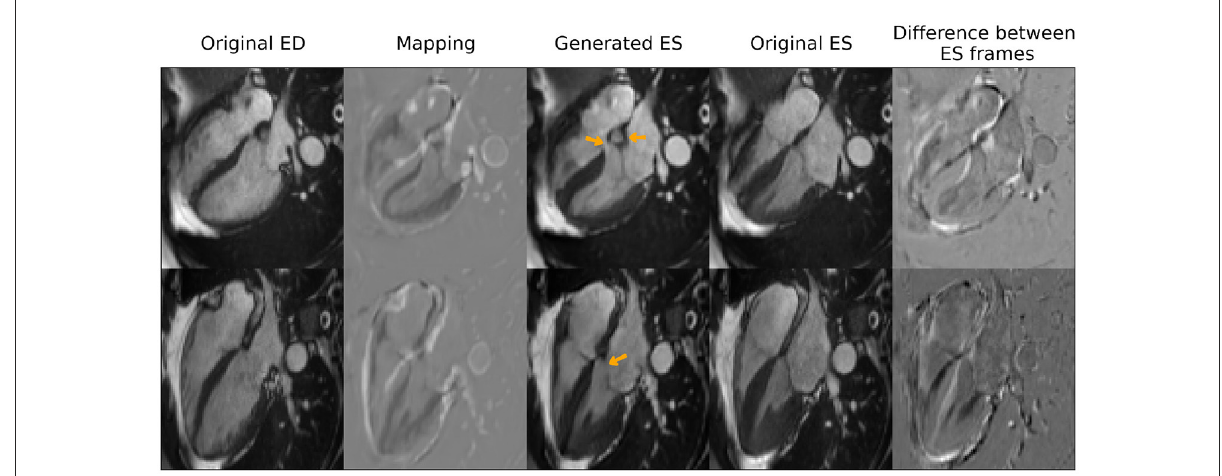
FIGURE5 Qualitative results for end-systole (ES) frame generation from end-diastole (ED) frames. Orange arrows highlight clinical inaccuracies of the generated images such as incomplete interventricular septum or mitral valve or an extra “blob” in between the atria. Reproduced by kind permission of UK Biobank ©